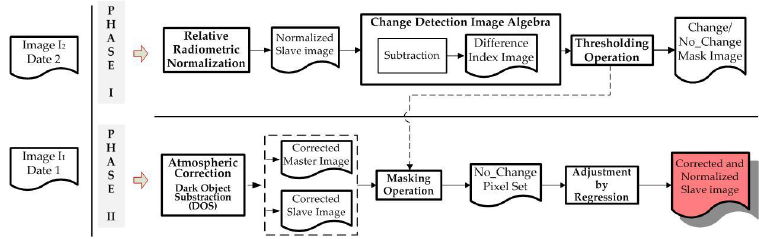
Figure 5. Suggested Radiometric Normalization Methodology.